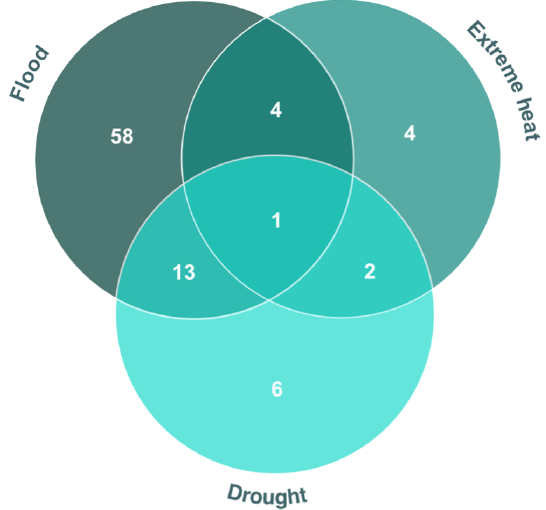
Figure 3. Hydro-meteorological risks addressed with different NBS practices in SSA.